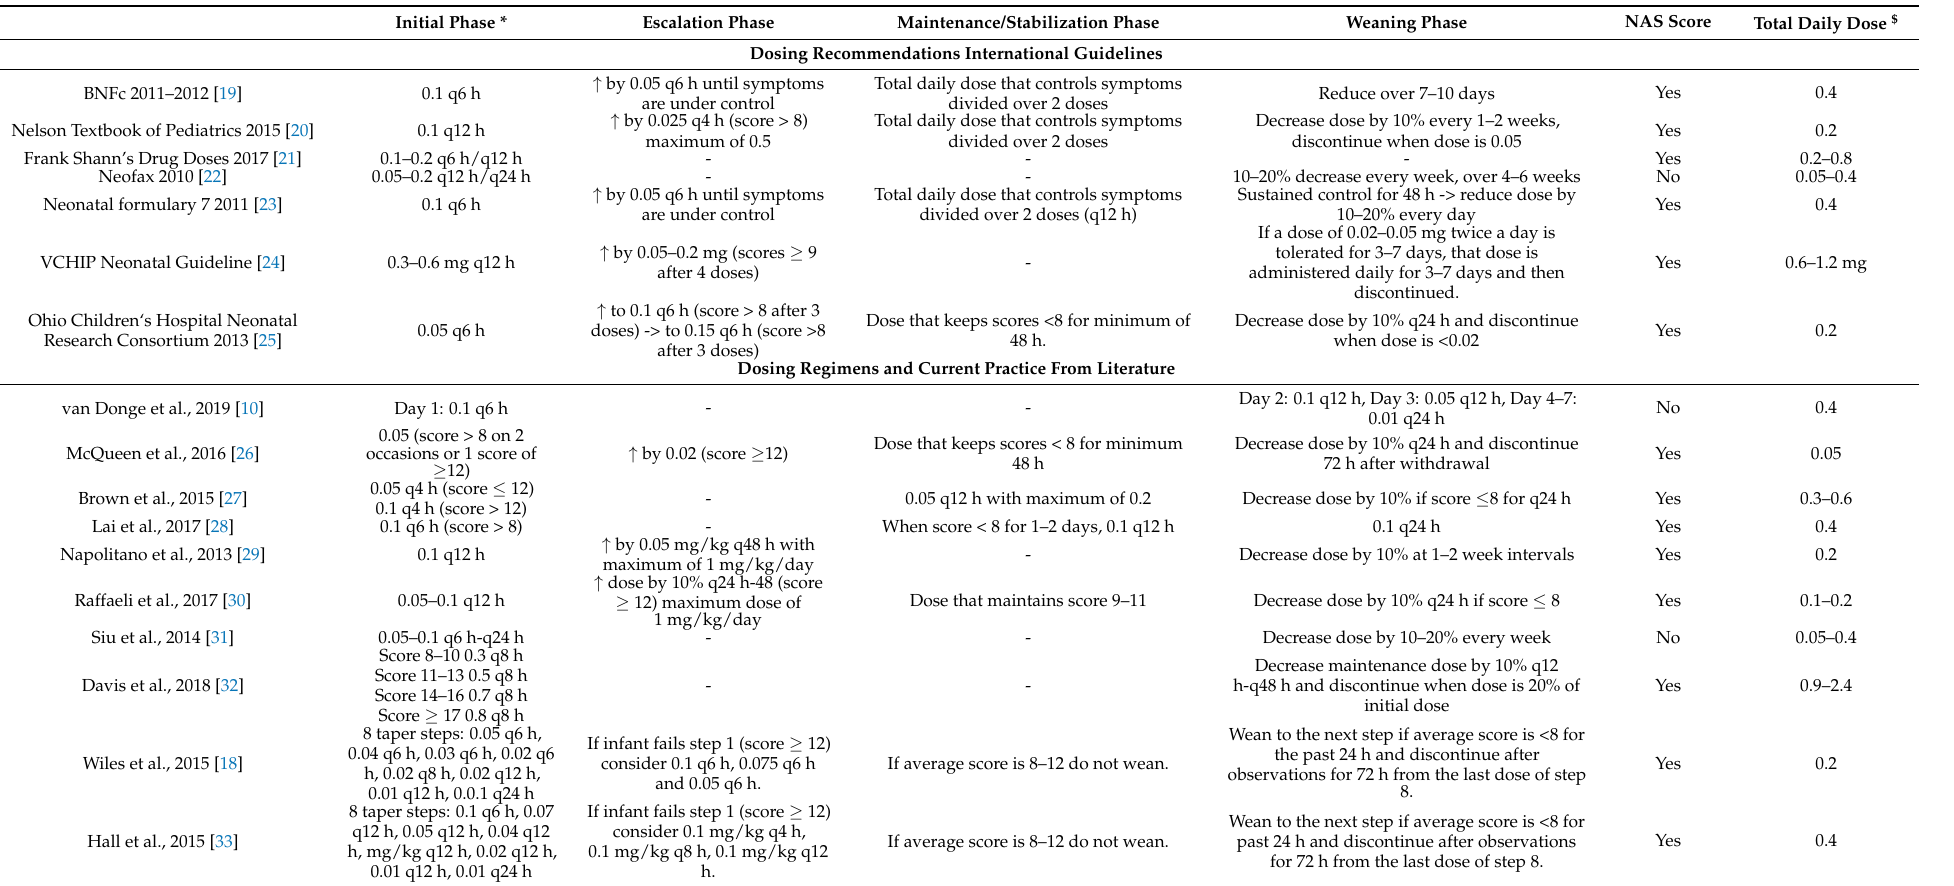
Table 1. Methadone dosing regimens for the treatment of neonatal abstinence syndrome collected from international guidelines and